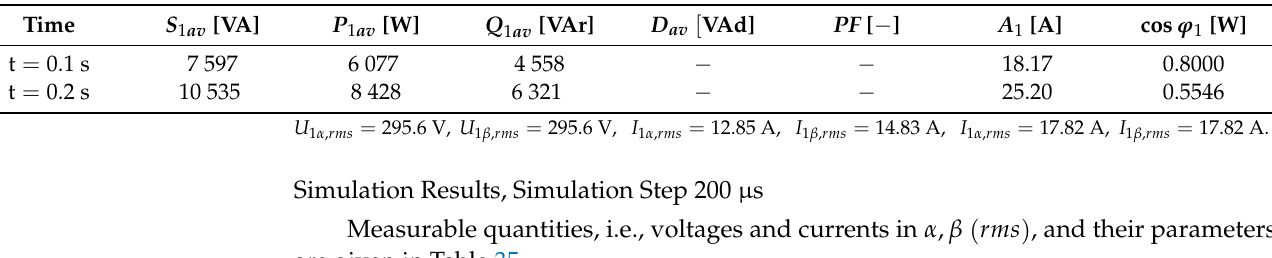
Table 35. Simulation results before and after the change (at steady states).